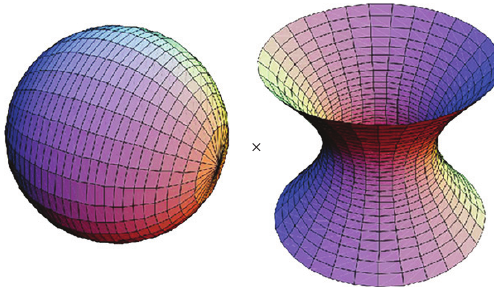
Figure 1: AdS 5 × S 5 . The five-dimensional anti-De Sitter space is represented as a hyperboloid on the right hand side, while the five-dimensional sphere is drawn on the left hand